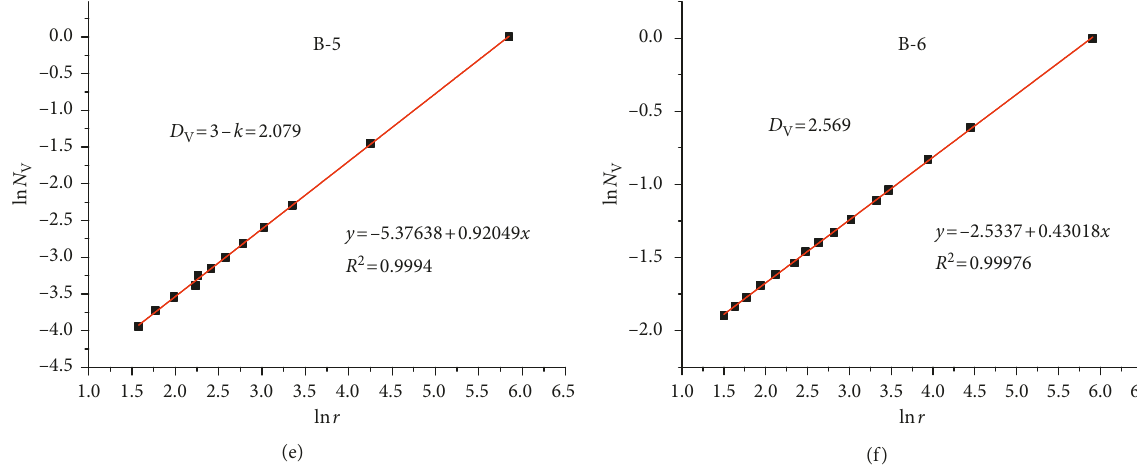
Figure 7: Calculation of pore volume fractal dimensions for the B-1 to B-6 coal